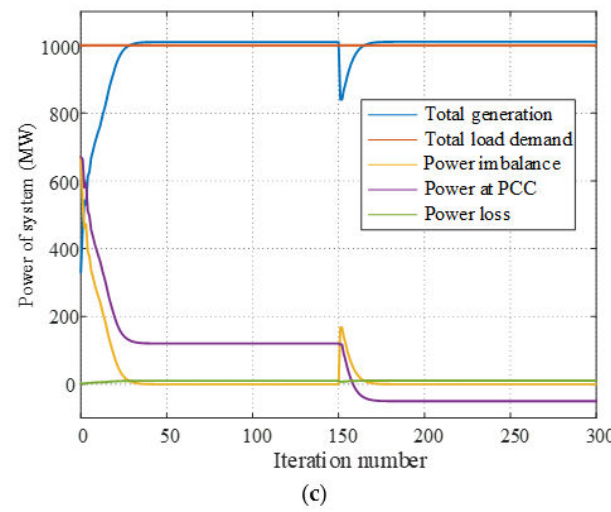
Figure 6. Simulation results of scenario 2. ( a ) Incremental cost; ( b ) power of each unit; ( c ) power information of the